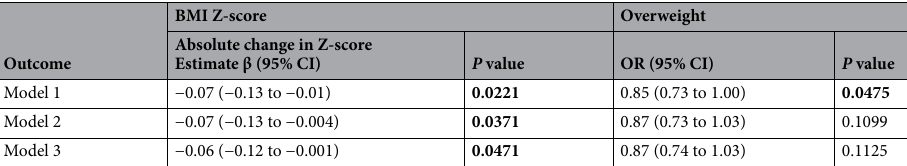
Table 3. Longitudinal analysis of anthropometric assessed during study visits from 1 to 4 years of age in offspring were large-for-gestational age and breast-feeding. LGA large-for-gestational age, BMI body mass index, CI confidence interval, OR odds ratio. Model 1: adjusted for maternal pre-pregnancy BMI; Model 2: adjusted for covariates in Model 1 + maternal age, education, and child sex; Model 3: adjusted for covariates in Model 2 + gestational diabetes